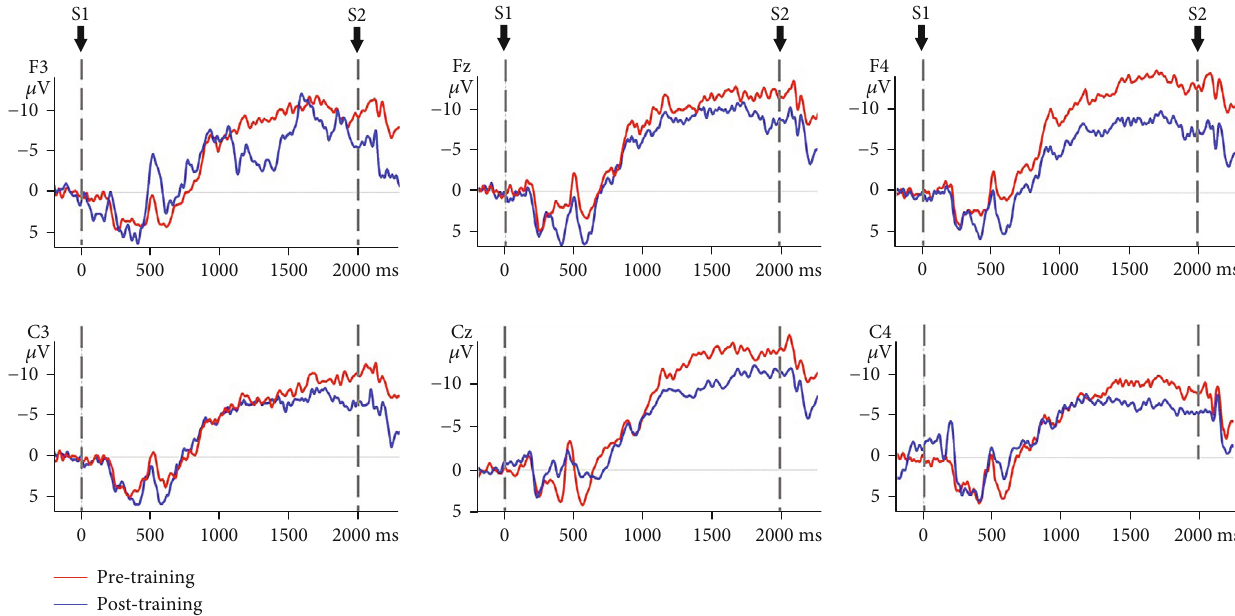
Figure 8: CNV amplitudes of the control group during paretic hand movement. Note: negative is plotted upwards. The 200 ms epoch prior to the S1 onset was the baseline CNV amplitude. The onset is at 0ms point and is the S1 trigger